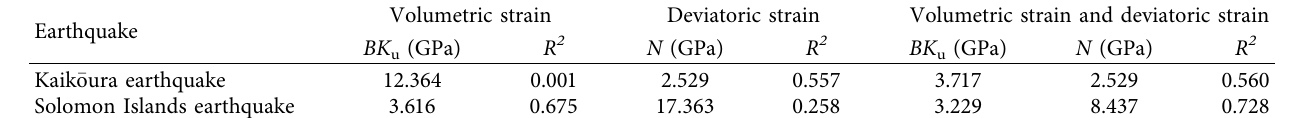
Table 2: Well-aquifer system parameters by seismic